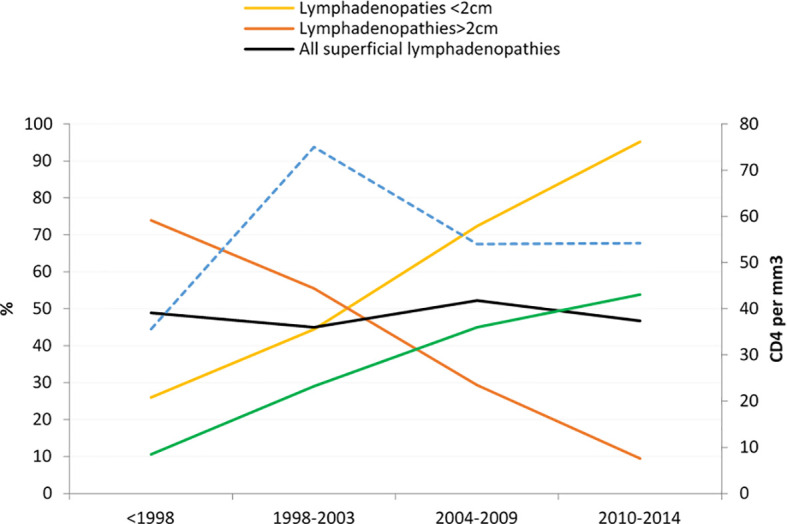
Evolution of the proportion of patients with lymphadenopathies by size.